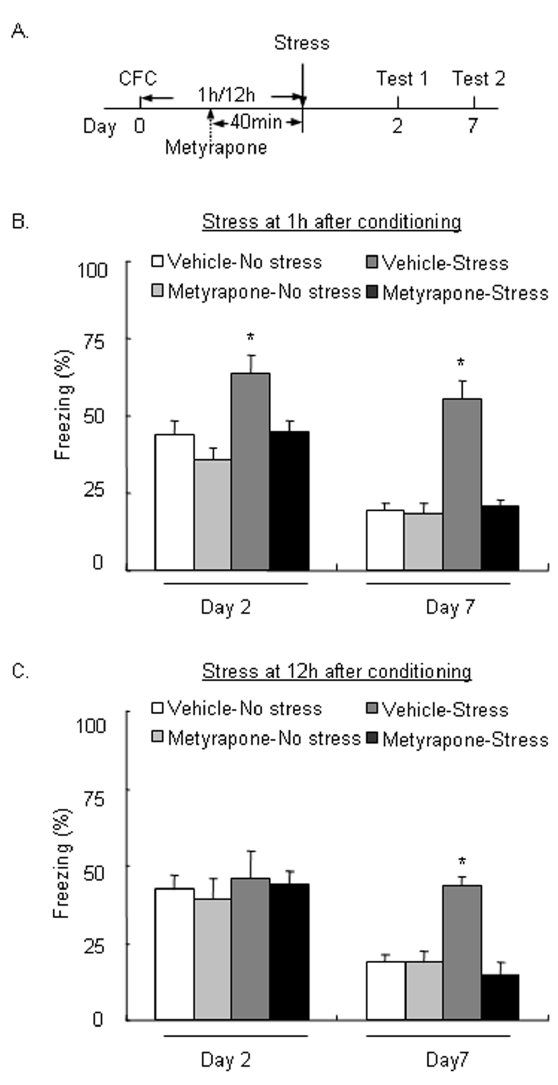
Figure 2. Metyrapone blocked the enhancement of long-term memory formation or persistence induced by stress after fear conditioning. (A) Rats were pretreated with the corticosterone synthesis inhibitor metyrapone 40 min before exposure to cold water stress 1 or 12 h after weak contextual fear conditioning (CFC) and then tested for long-term memory (LTM) on day 2 and day 7. (B) Metyrapone blocked the effects of stress 1 h after CFC on LTM formation on day 2 and reduced the persistence of LTM tested on day 7. (C) Metyrapone blocked the effects of stress 12 h after CFC on the persistence of LTM tested on day 7, leaving LTM formation tested on day 2 intact. The data are expressed as mean 6 SEM ( n =6 per group). * p , 0.05, compared with Vehicle-No stress